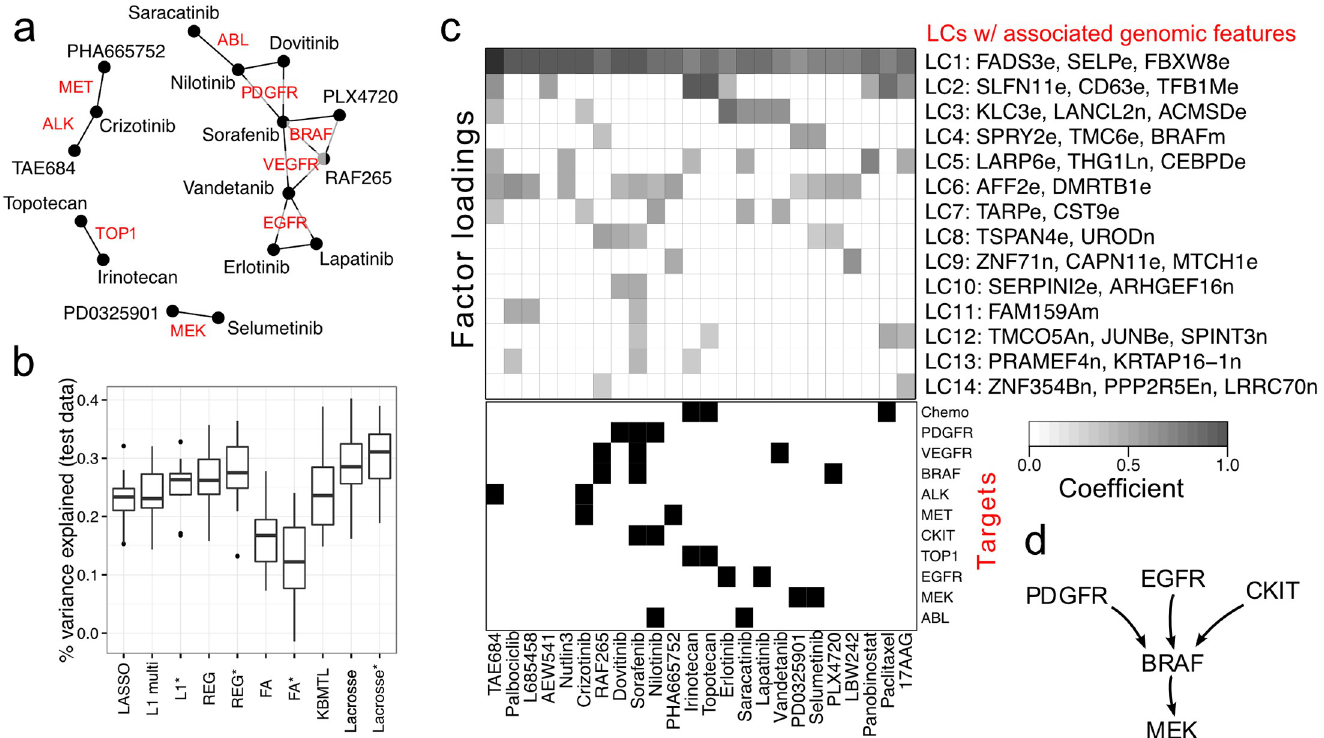
Fig 2. Lacrosse combines prior knowledge (shared inhibition targets) and observed similarity between drugs to improve predictive performance and define overlapping clusters of drugs with related dependence on genomic features. a . A Markov random field (MRF) is used to encode prior knowledge of which drugs share inhibition targets. Lacrosse does not use the inhibition targets themselves, only that if two drugs share an inhibition target then they are more likely to share sensitivity to a particular latent characteristic. b . Predictive performance results on CCLE. Here LASSO = L1 regression, REG = spike & slab regression. Lacrosse = discriminative factor analysis. In general incorporating prior knowledge about between drug relationships (the methods denoted with � ) improves predictive performance. The Bayesian spike and slab regression based methods (REG and Lacrosse ) also perform somewhat better than the L1 optimization method (LASSO, L1 multi, and L1 � ), although this comes at considerable computational expense. The factor analysis models (FA and FA � ) have quite poor performance, likely to due to not being discriminative. The performance of KBMTL is similar to that of LASSO. c . Lacrosse � factor loadings: 14 latent characteristics (LCs) × 24 drugs, known targets for each drug, and associated gene features (i.e. non-zero coefficients in B ) for each LC. Encoding of gene features: e = expression, n = copy number variation, m = mutation. d . A highly simplified layout of the MAPK pathway associated with latent characteristic